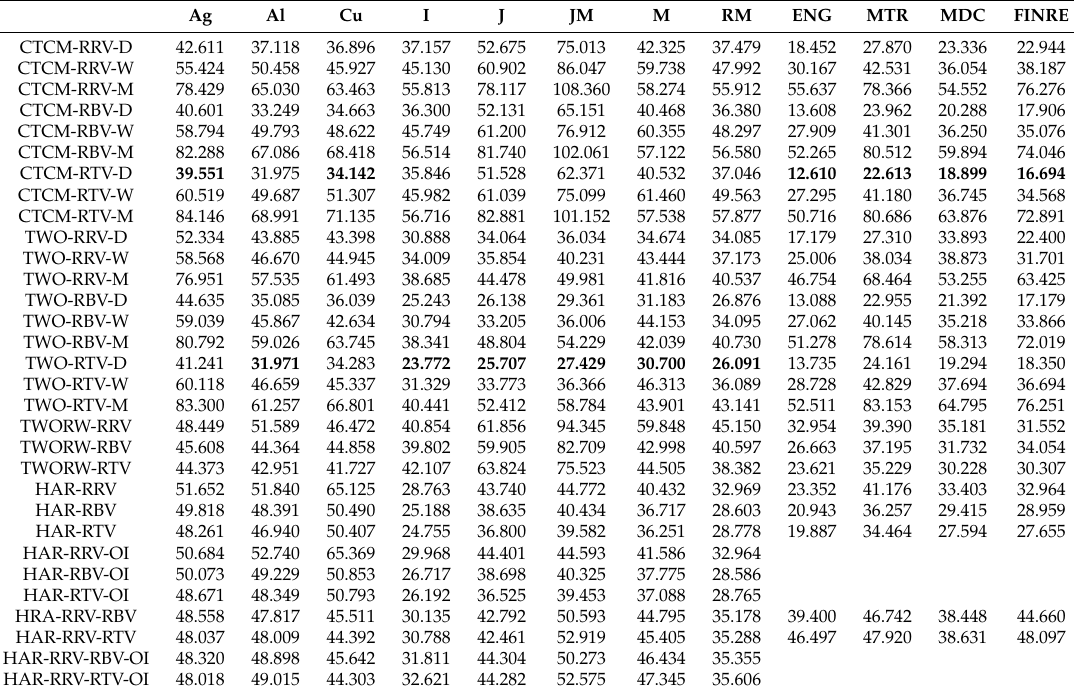
Figure 3. Model HAR-RTV-OI Estimation for I(DCE). The horizontal line is the timeline, and the perpendicular line is the volatility estimator. The actual values are represented by the blue line, while the estimated values are represented by the orange line. The estimated values are close to the actual values, and the trend of volatility is smooth, especially after Day 300. Table 5. The results of out of sample forecast